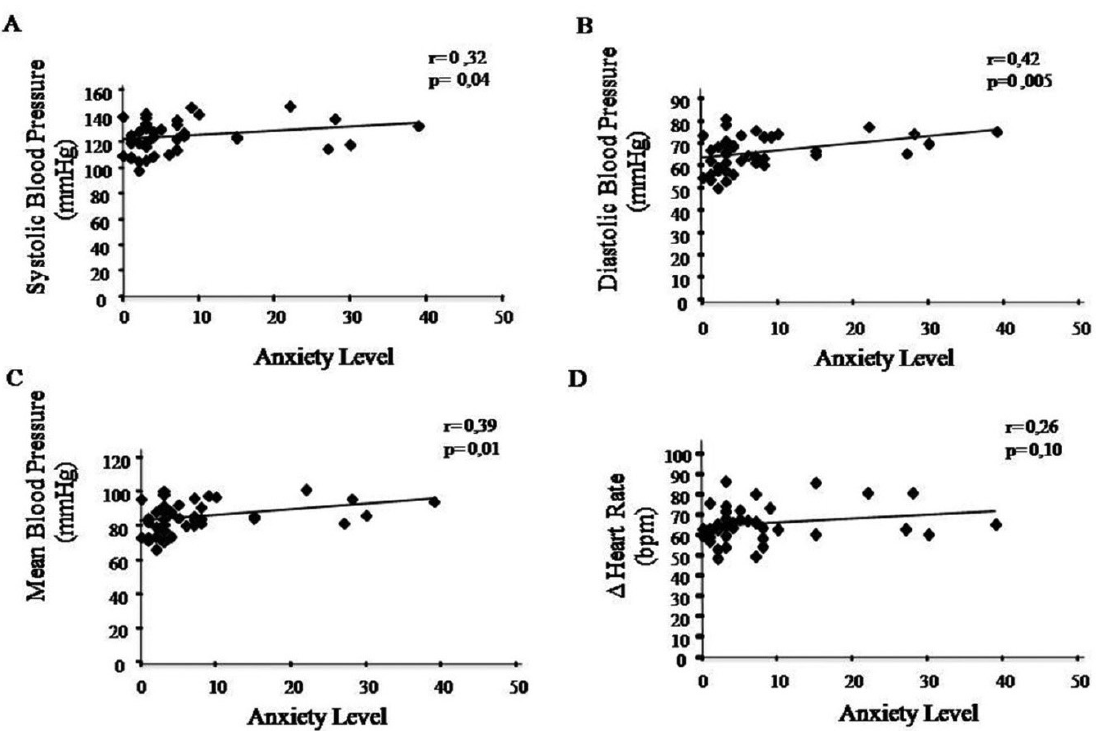
Figure 5. Relationships between anxiety level and systolic, diastolic, and mean blood pressure and heart rate levels (panels A, B, C, and D, respectively) during the rest period. Note that the anxiety level showed directly proportional correlations to systolic, diastolic, and mean blood pressure levels. We did not observe a correlation between anxiety level and heart rate.